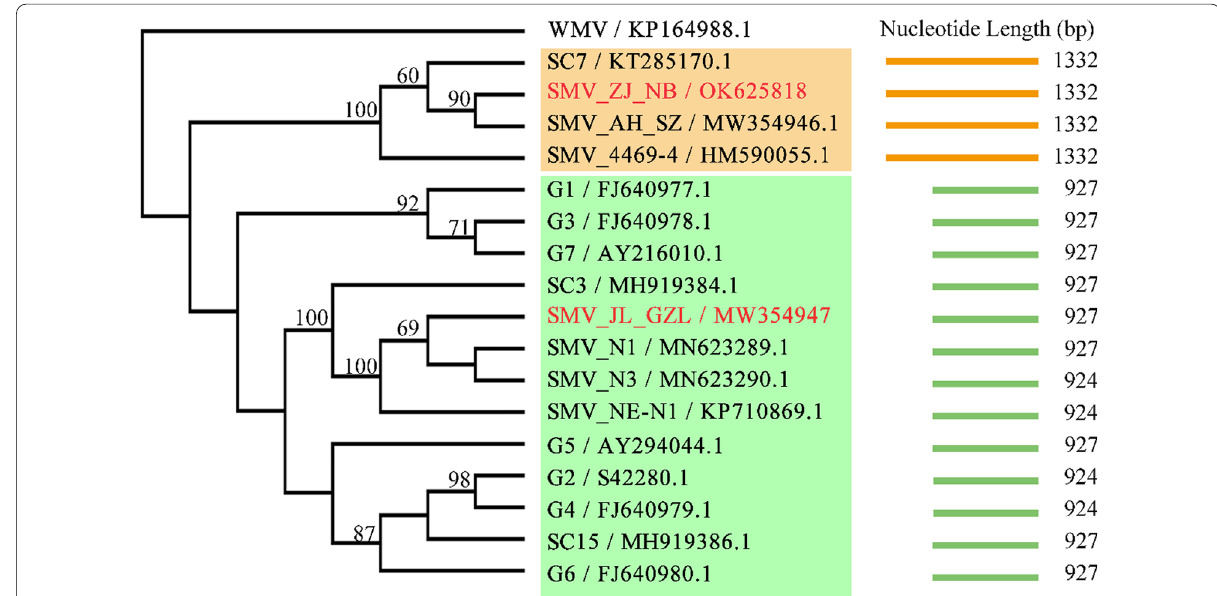
Fig. 5 Phylogenetic relationship among the P1 proteins of soybean mosaic virus (SMV) isolates from different countries. The phylogenic tree was constructed using MEGAX. The nucleotide sequence of P1 protein were obtained from NCBI (https:// www. ncbi. nlm. nih. gov/). The colored bars (orange and green) indicate the different clades observed in the phylogenies. The sequence length of P1 protein is shown in the right